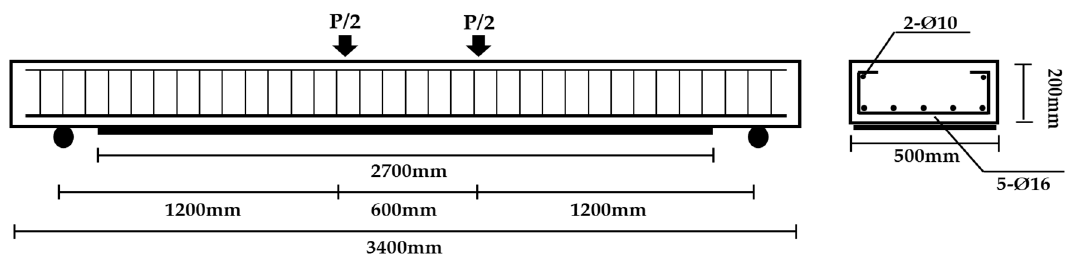
Figure 1. Configuration and dimension of a specimen.